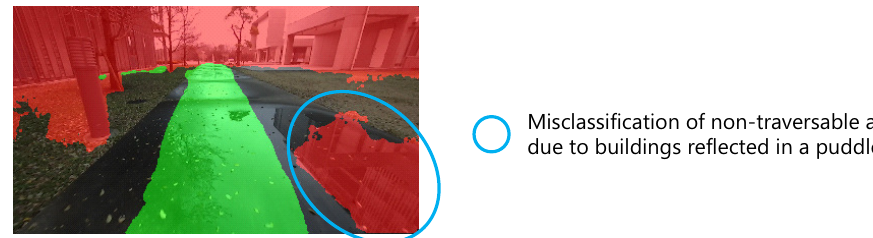
Figure 20. Example of misclassification of non-traversable areas due to non-traversable objects reflected in a